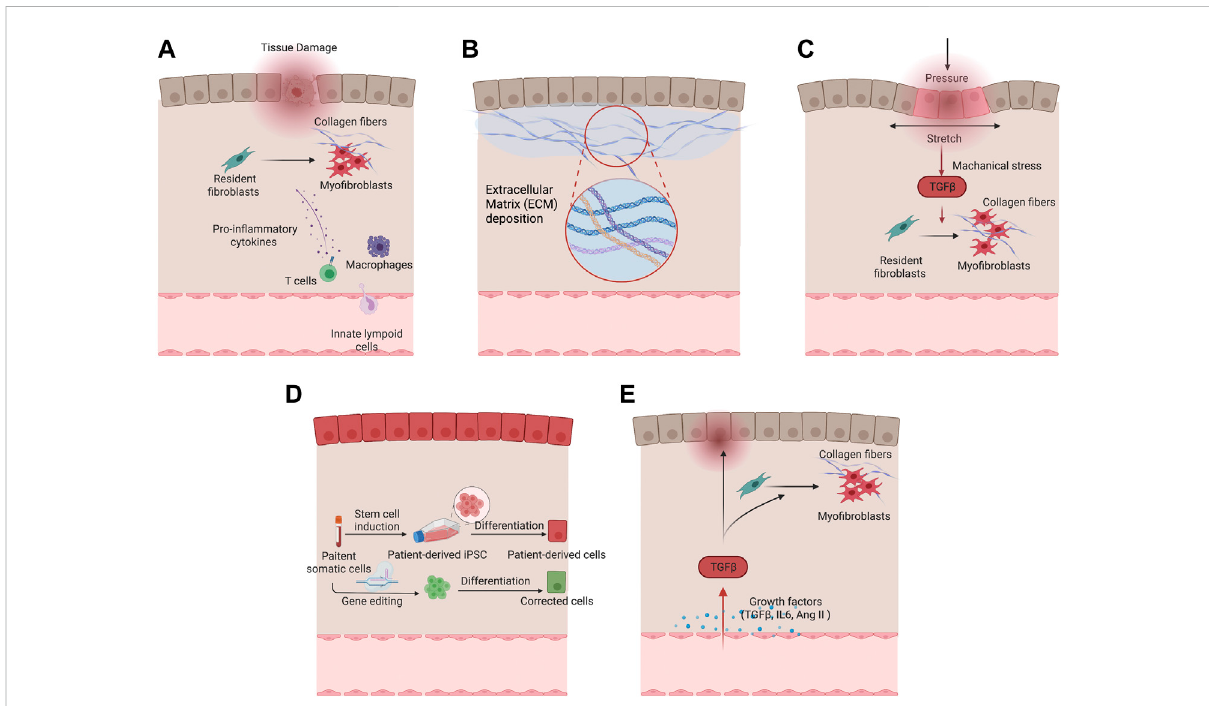
FIGURE 2 Different pathological factors of fi brotic remodeling. (A) Cellular factors underlying fi brotic remodeling. (B) Increased extracellular matrix deposition in fi brotic condition. (C) Mechanical stimulation drives myo fi broblast activation and fi brotic remodeling. (D) Genetic predisposition in tissue and vascular cells with patient-derived cells serving for fi brotic disease modeling. (E) Growth factors including TGF- β and Ang II in fi brosis